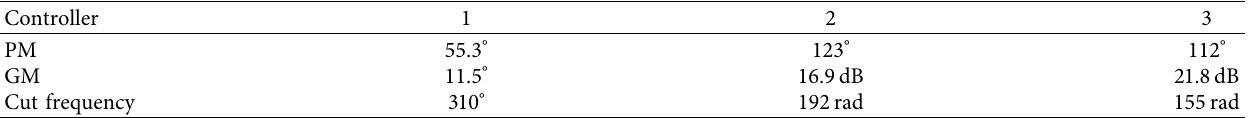
Figure 7: Bode plots of T 2 and 1/ W 2 of (a) controller 1, (b) controller 2, and (c) controller 3. Table 4: Condition parameters of the